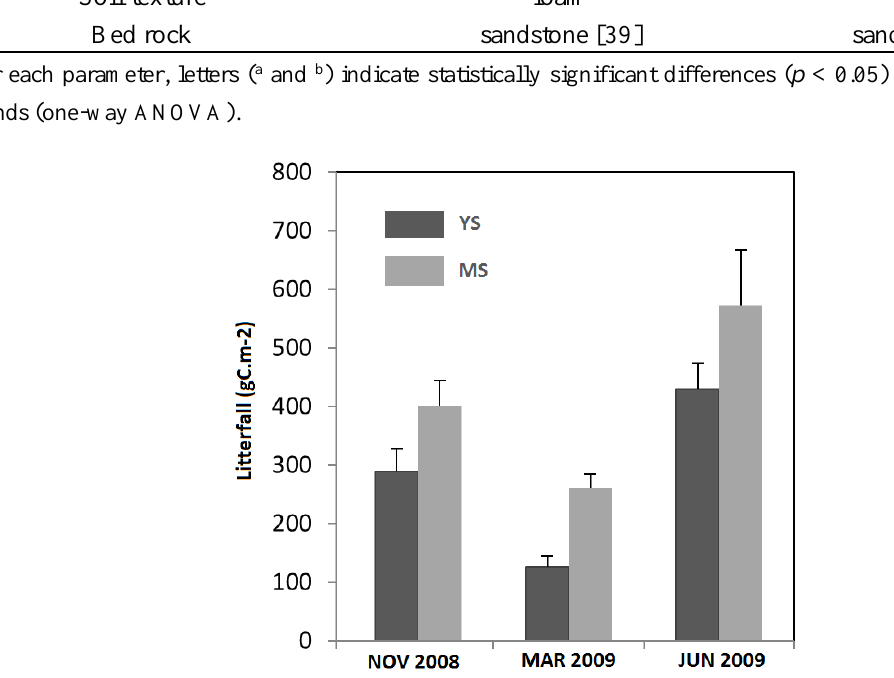
Figure 3. Seasonal litterfall (gC m −2 ) measured on the young stand (YS) and the mature stand (MS) in 2008 and 2009. Error bars are standard errors of the